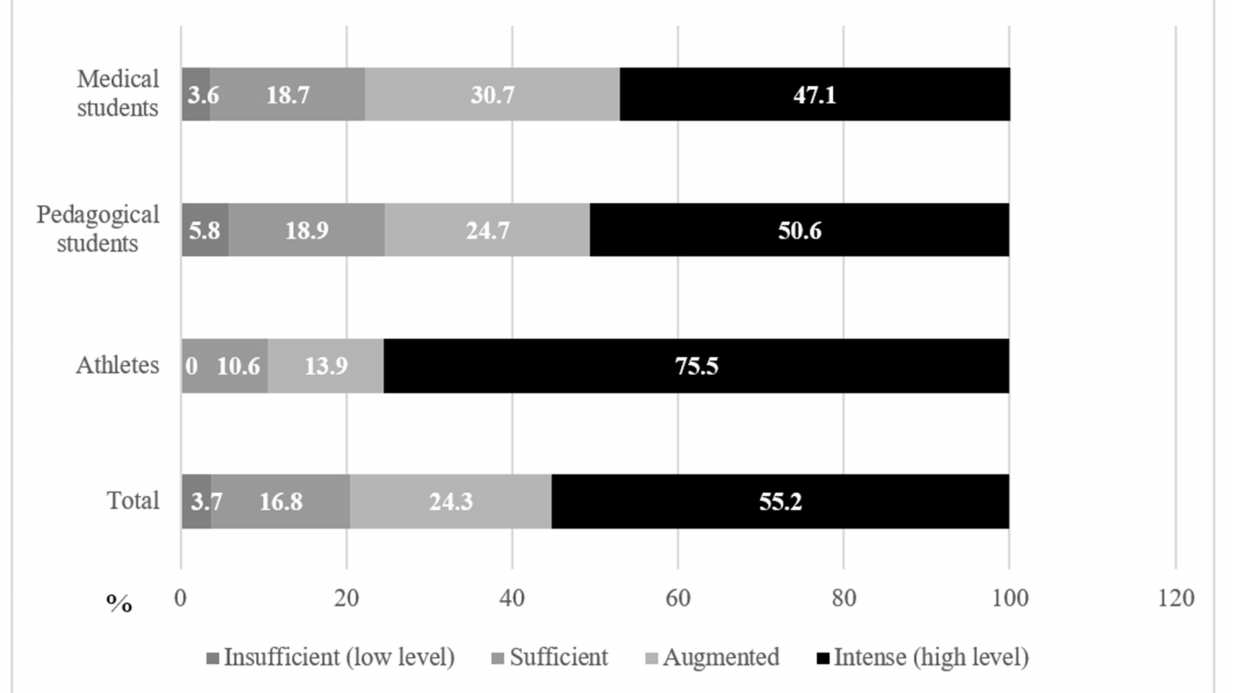
Figure 1. Proportion of different types of physical activity (PA) declared by the